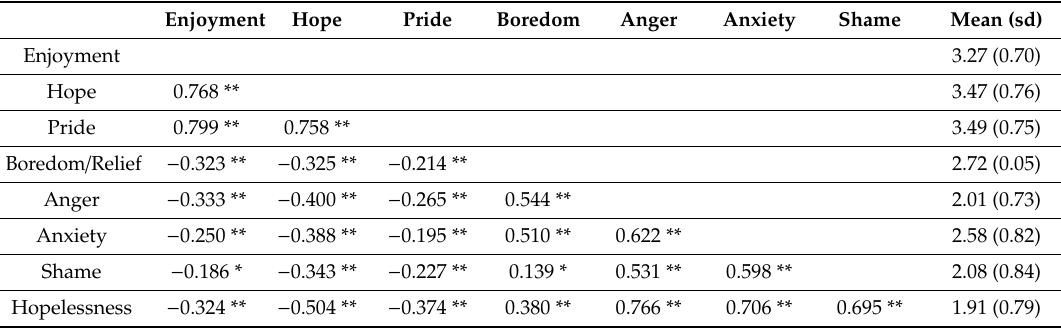
Table 2. Correlation between achievement emotions ( n = 520).